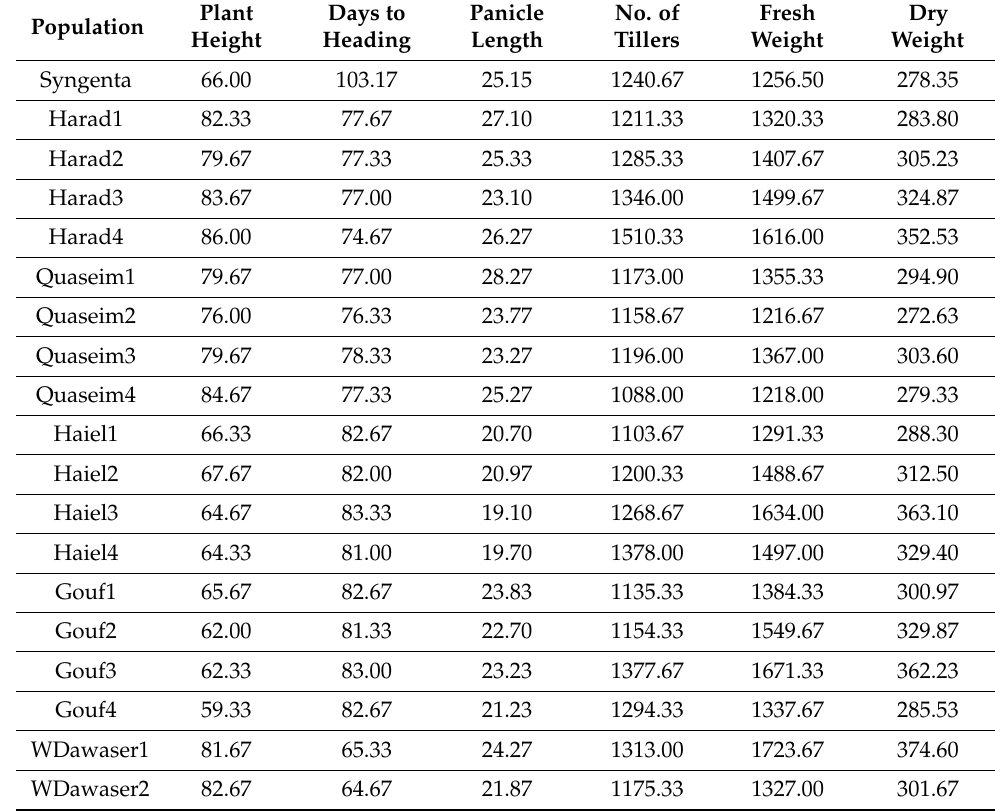
Table 4. Means of the traits’ performances for the tested Lolium